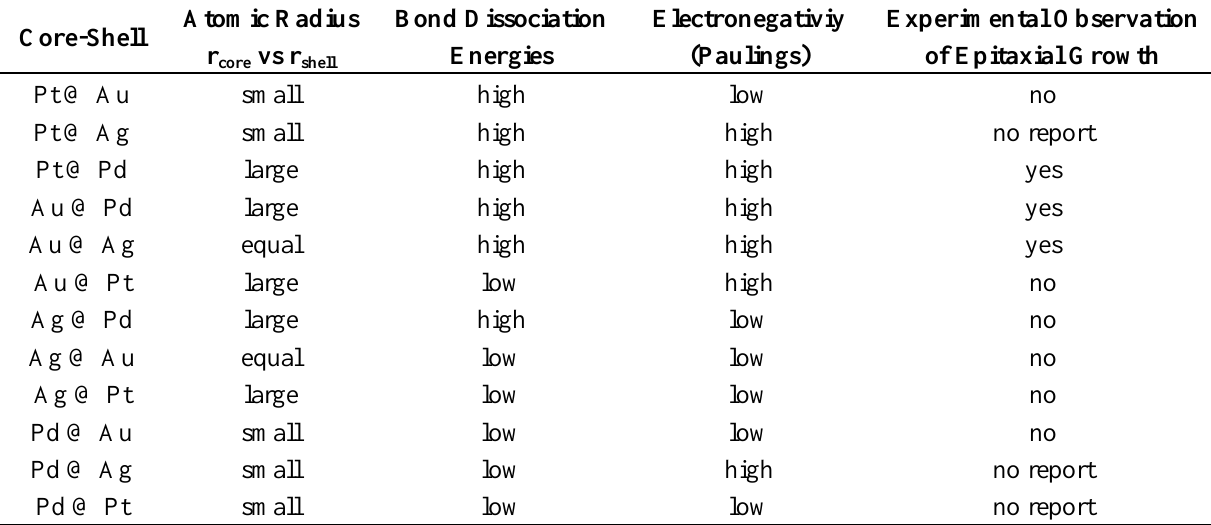
Table 1. Comparison of physical constants between the core metal and the shell metal in various combinations of binary metal nanocrystals (reprinted with permission from [107]. Copyright (2008) American Chemical